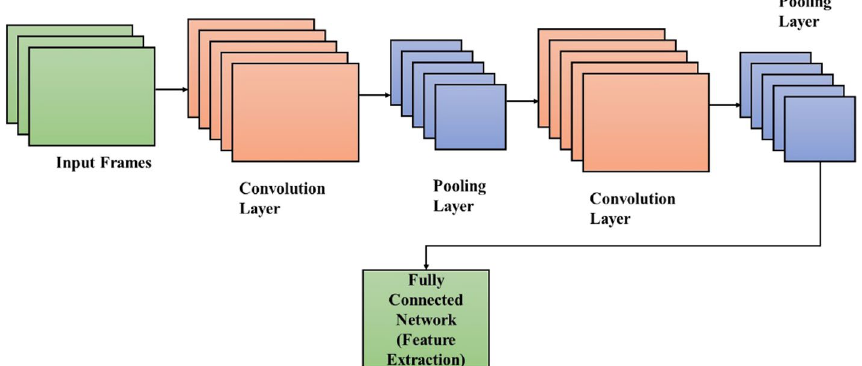
Fig. 2 Convolutional neural network on the feature